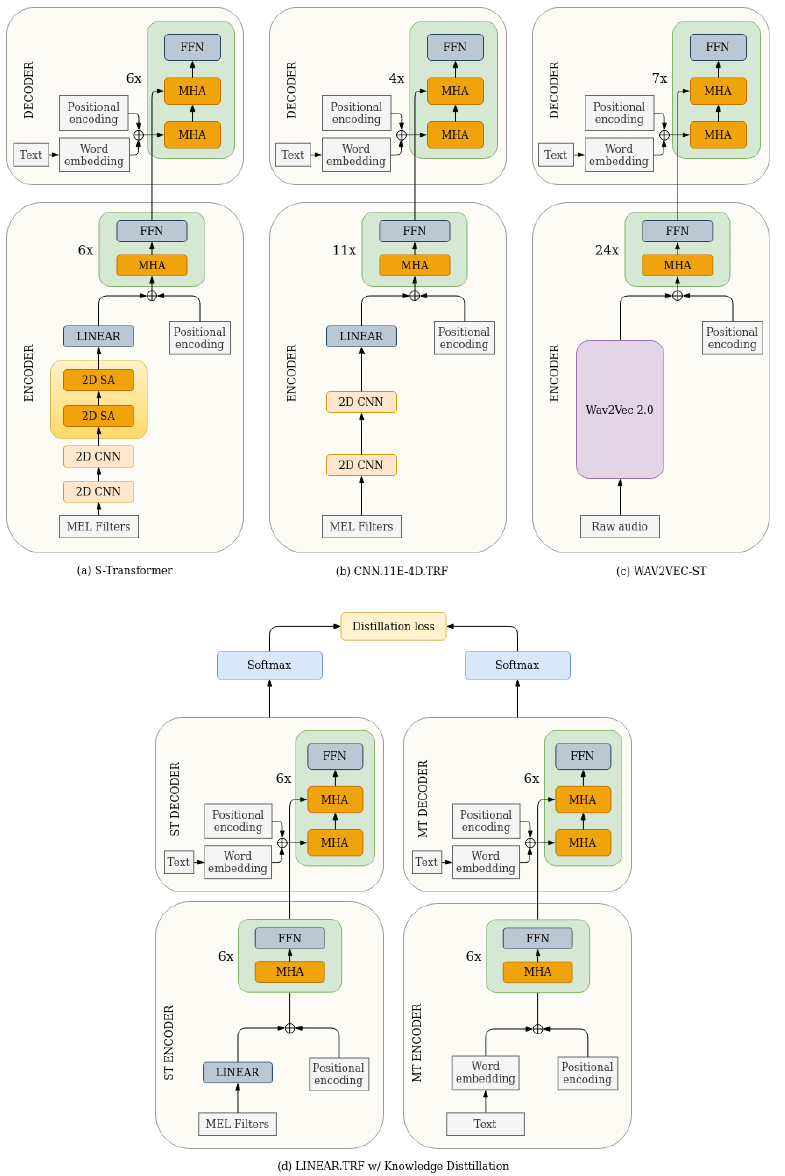
Figure 2. Architectural variants for end-to-end models. FFN denotes the Feed-Forward Networks in a standard Transformer architecture; MHA denotes Multi-Head Attention; CNN denotes convolu- tional